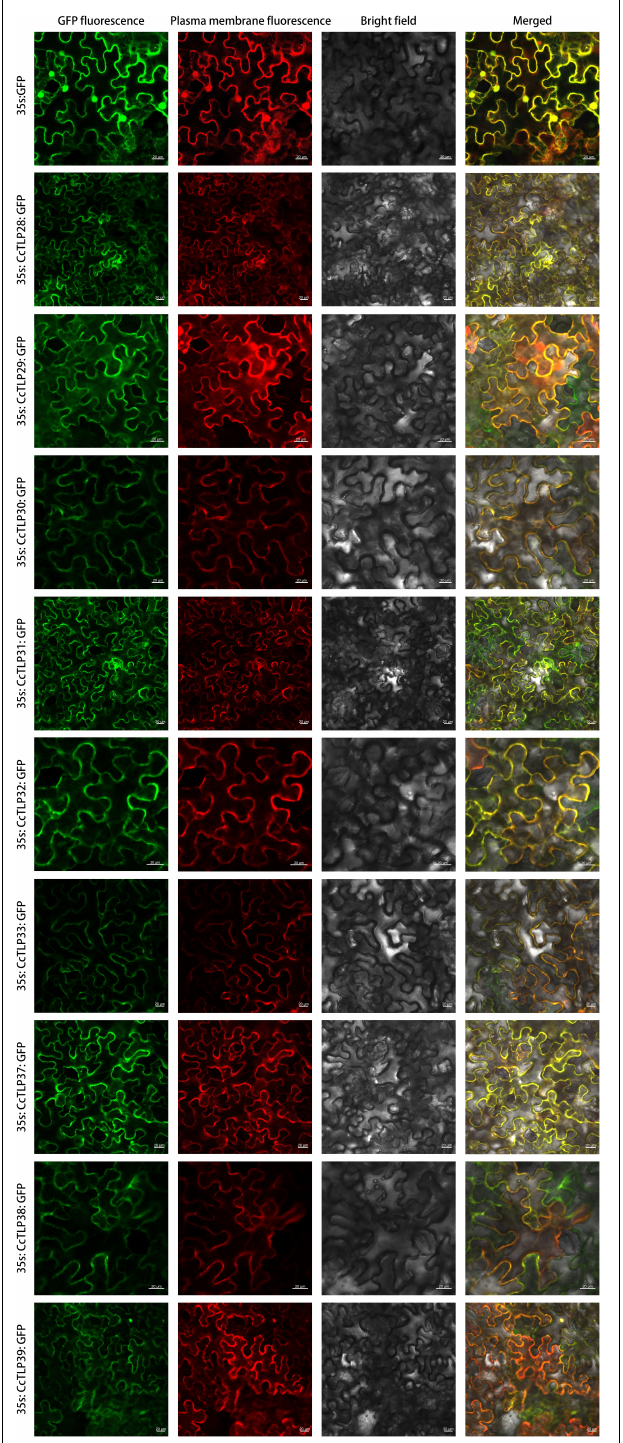
FIGURE 8 | The subcellular localization analysis of the CcTLP28, CcTLP29, CcTLP30, CcTLP31, CcTLP32, CcTLP34, CcTLP37, CcTLP38 , and CcTLP39 in Nicotiana. benthamiana . The transient expression of the 35S::CcTLP-EGFP fusing construct and the 35S::EGFP construct in N. benthamiana . Green fluorescent protein (GFP) fluorescence was observed 3 dpi using a confocal microscope. Scale bars: 20 µ